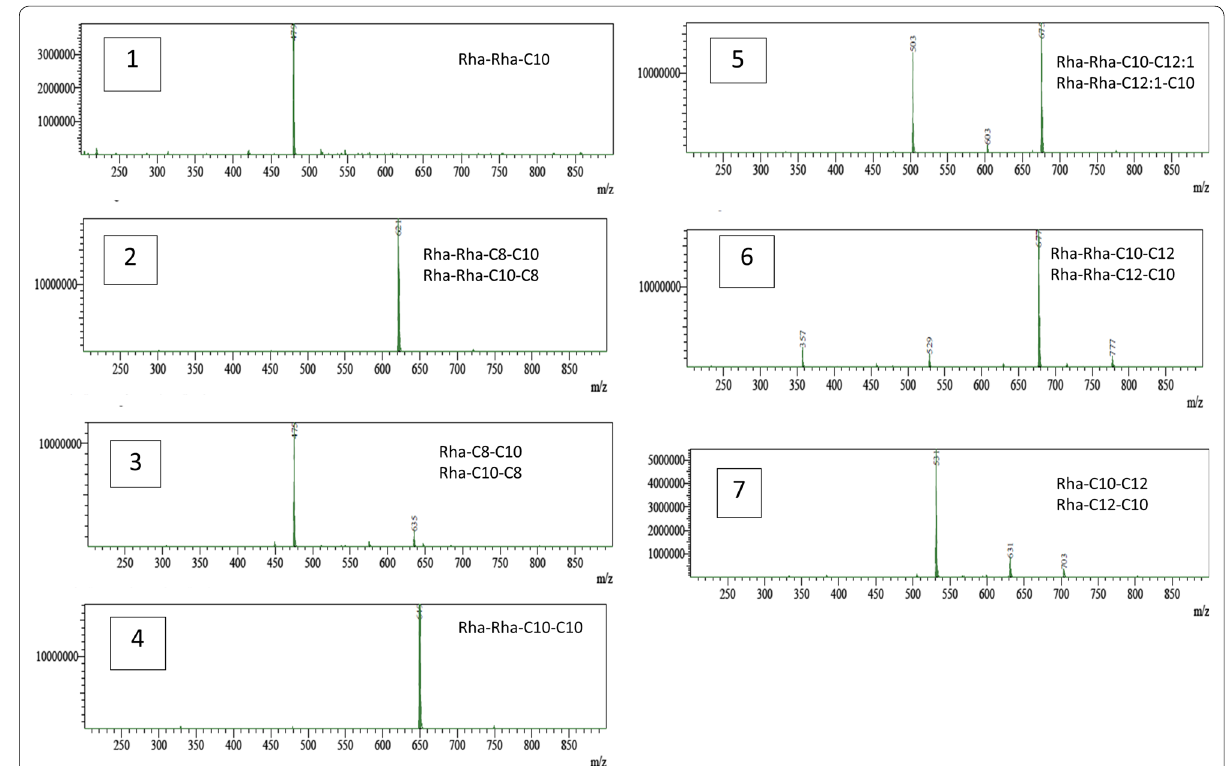
Fig. 3 MS spectra of the RLs extracted from P. aeruginosa P6. Top right corner shows the suspected formula of the RLs. X‑ and Y‑axis indicate m/z (mass to charge ratio) and intensity, respectively